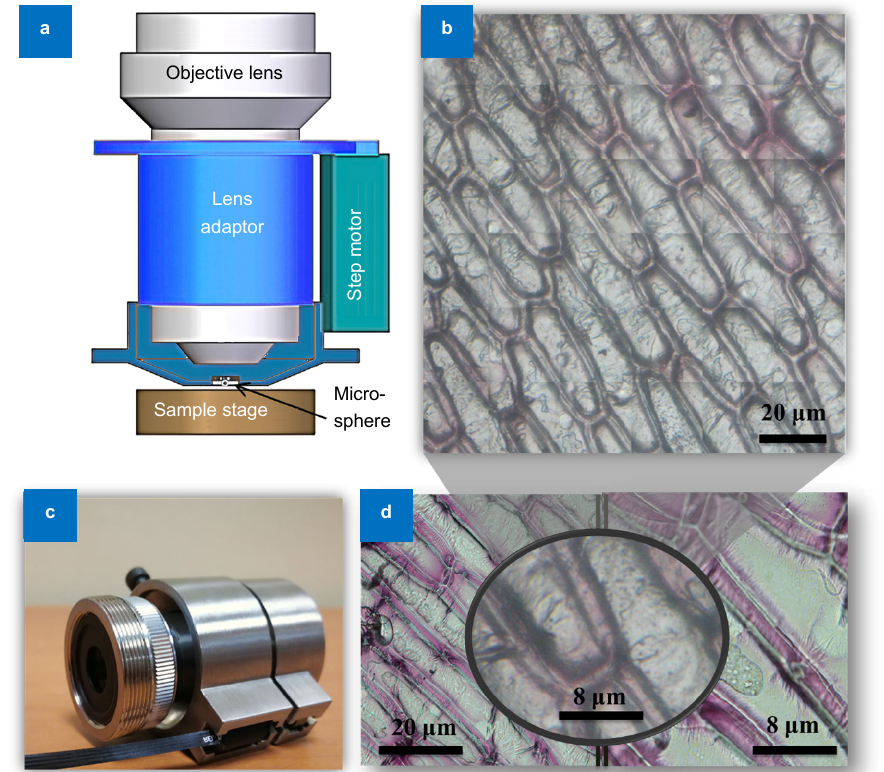
Fig. 2 | ( a ) Schematic of the design of the universal lens adaptor for the microsphere (silica microsphere with 400 μ m diameter attached on a 20× objective lens. Characterization was done in ambient air and distance between the onion cell and the microsphere is ~65 μ m, with white light illumination). ( b ) Integrated image of onion cells (scale bar: 20 μ m). ( c ) Optical image of the universal sample adaptor after integration. ( d ) Comparison of the optical images by three optical lenses: the 20× objective lens (left, scale bar: 20 μ m); 20× objective lens with the microsphere (middle, which is our nanoscope design, scale bar: 8 μ m); and 50× objective lens (right, scale bar: 8 μ